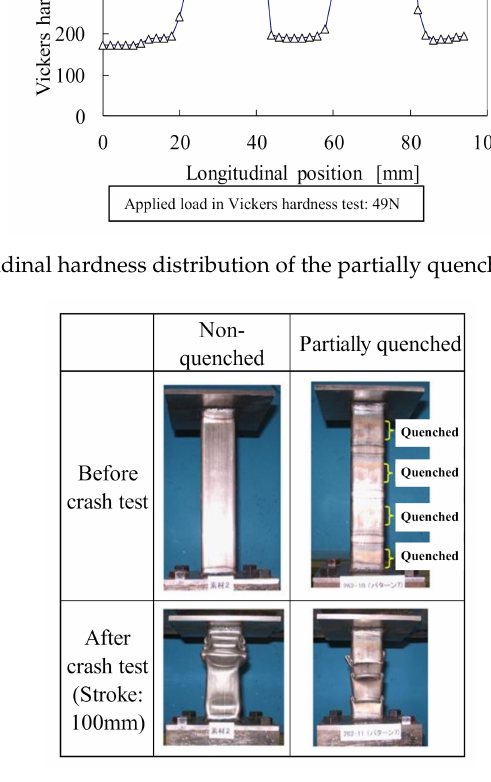
Figure 9. Deformation of the partially quenched straight tube in the axial crash test.